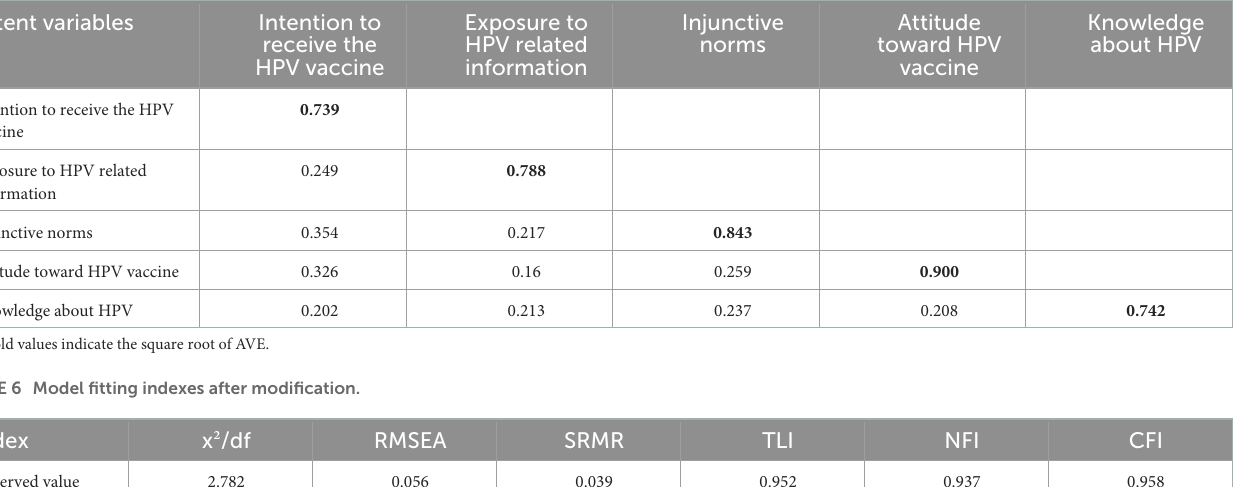
TABLE 5 Discriminant validity testing results.